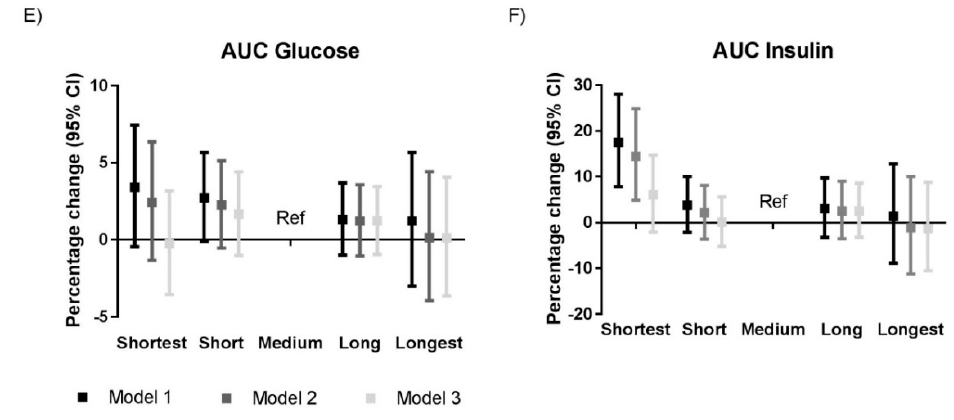
Figure 1. Associations between sleep duration and ( A ) fasting glucose, ( B ) fasting insulin, ( C ) HOMA-IR, ( D ) HOMA- β , ( E ) AUC of glucose, and ( F ) AUC of insulin. Results were based on analyses weighted towards the BMI distribution of the general Dutch population ( n = 4672) and were derived from regression coefficients with 95% confidence intervals from linear regression analyses and expressed as percentage change in outcome measure, as compared to the medium sleep duration group as reference category. Model 1: Adjusted for age and sex; Model 2: Adjusted for age, sex, ethnicity, education level, smoking, alcohol intake, caloric intake, and physical activity; Model 3: Adjusted for Model 2 + risk of sleep apnea and BMI. Abbreviations: AUC, area under the curve; CI, confidence interval; HOMA-IR, homeostatic model of insulin resistance; HOMA- β , homeostatic model of β cell function; Ref, reference category. n = 4511 for the analyses with AUC glucose and n = 4586 for the analyses with AUC insulin.